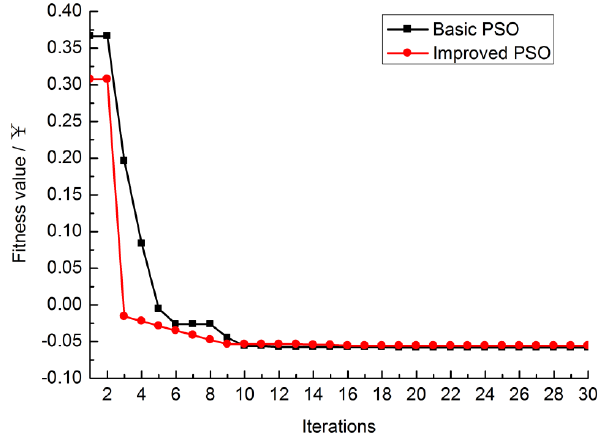
Figure 4. Convergence of fitness